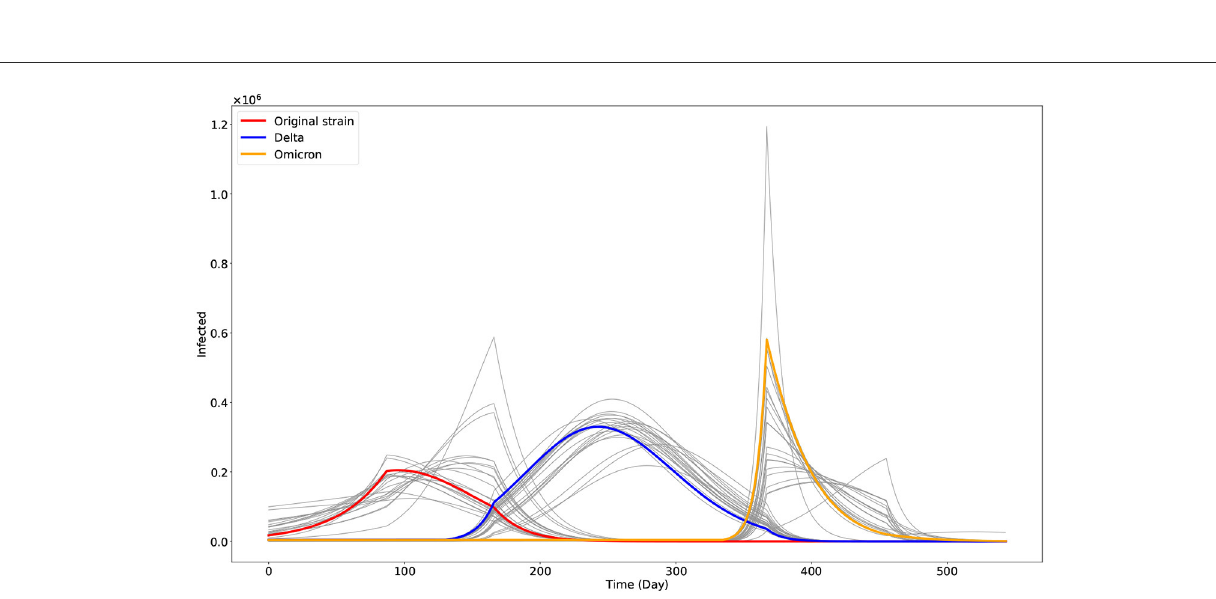
FIGURE3 Plot of the three dominant COVID-19 variants in the Philippines as given by the model. The gray curves are the other outputs of the approximate Bayesian computation approach. The red, blue, and orange curves represent the best fit model output associated with the original strain ( I 1 ), Delta ( I 2 ), and Omicron ( I 3 ) variants,